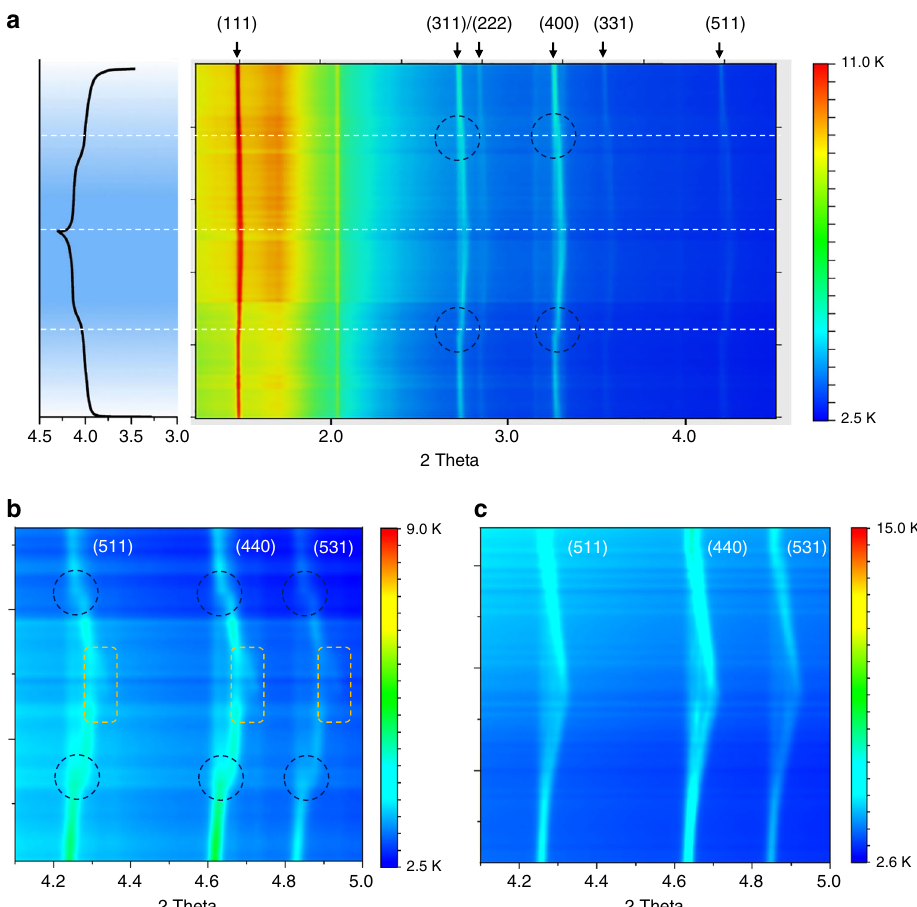
Fig. 1 In situ synchrotron HEXRD characterization on the structural evolution of LMO and LR-LMO during the fi rst charge/discharge. a The in situ XRD curve of the fi rst charge and discharge process and fi rst cycle electrochemical pro fi le for LMO; b enlarged fi gure of Bragg peaks (511), (440), and (531) for LMO; c enlarged fi gure of Bragg peaks (511), (440), and (531) for